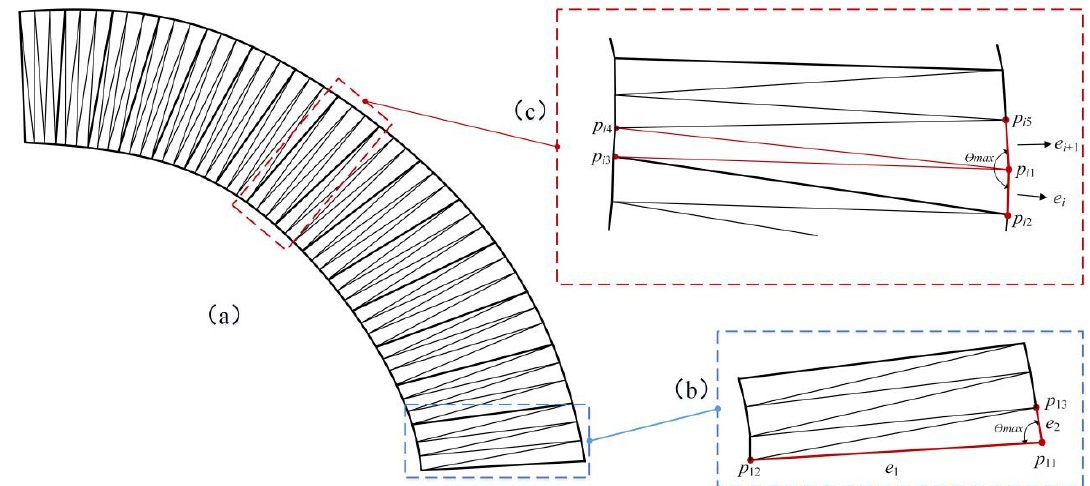
Figure 7. Illustration of the boundary extraction for a spiral stair: ( a ) X-Z projection image of a spiral stair, ( b ) details of the red rectangle, and ( c ) details of the blue rectangle.